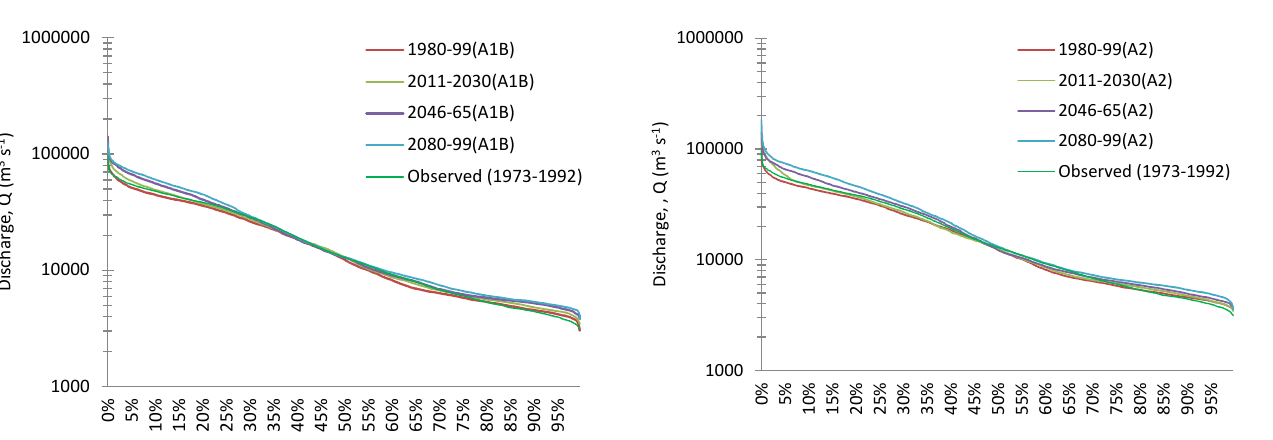
Fig. 5. Flow duration curve for observed and multi-model weighted discharge of A1B scenario of four different time slices.